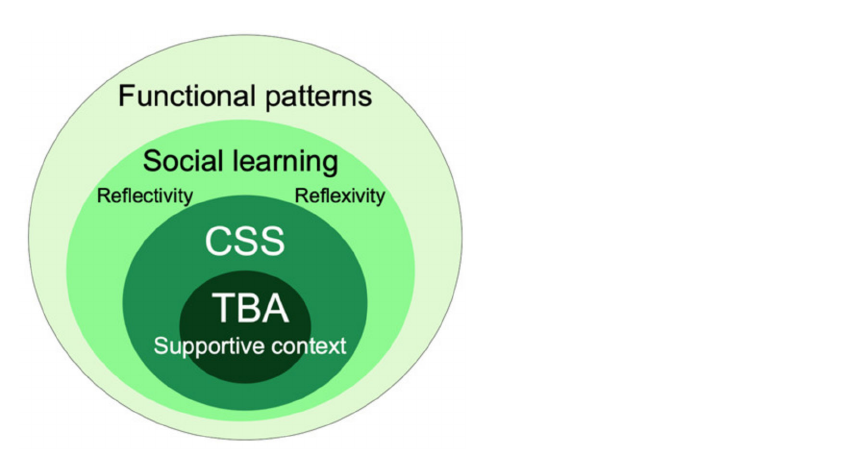
Figure 7. Trust-based approaches (TBA) and collaboration supporting structures (CSS) providing the core for SL and functional process and interaction patterns.